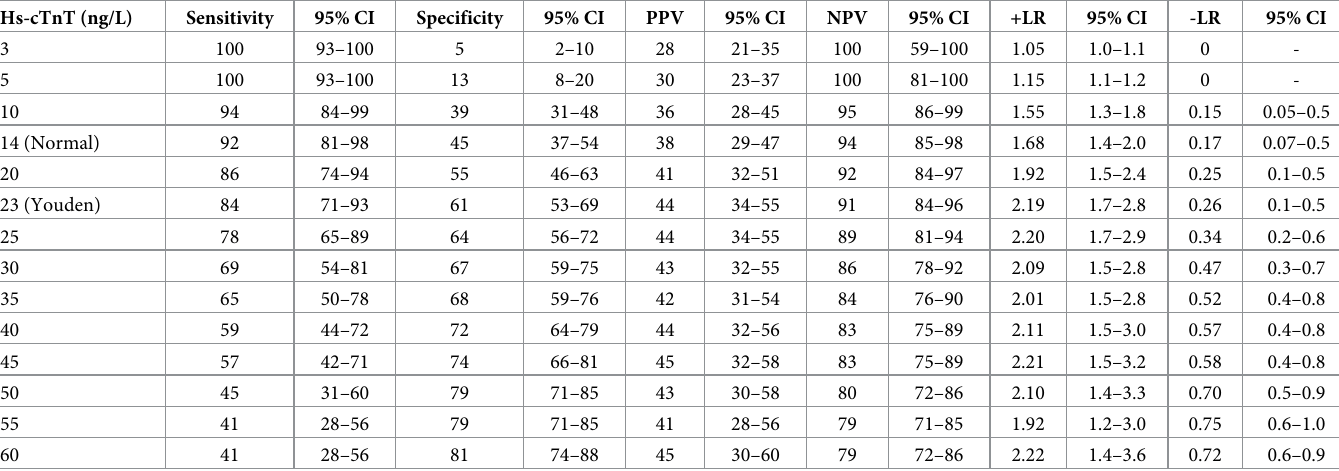
Table 4. Diagnostic parameters of hs-cTnT thresholds for inpatient mortality.